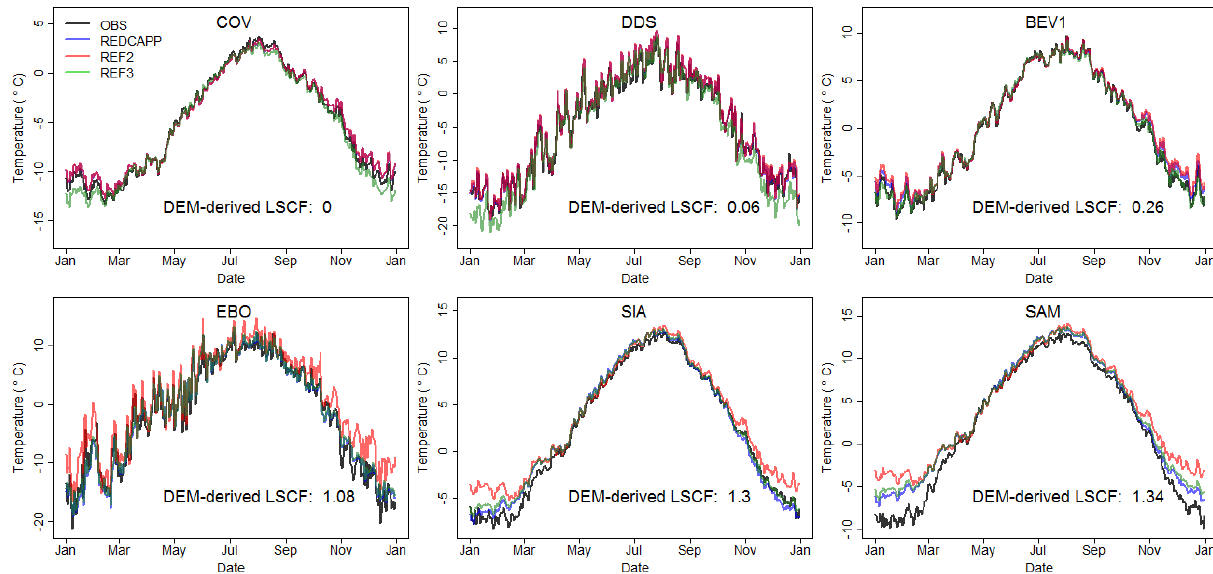
Figure 13. Comparison of REF2, REF3 and REDCAPP with time series at selected stations. The daily temperatures present are averaged based on all available years (Table 3); the shorter time series for EBO explains the larger variation in the plot.